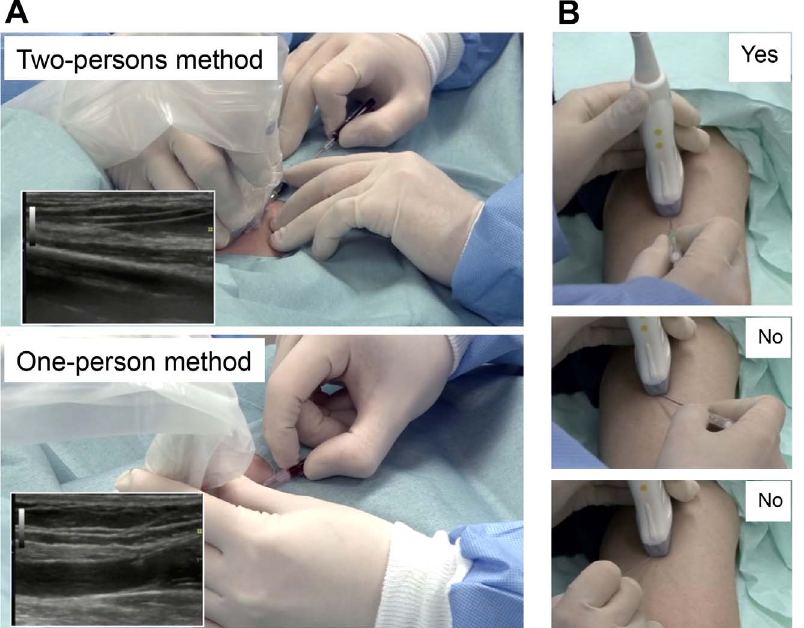
Figure 5. Real-time ultrasound-guided venipuncture. ( A ) ‘‘Two-person method’’ and ‘‘one-person method.’’ With the ‘‘two-person method,’’ the ultrasound-guidance step and the puncturing step are assigned separately to two operators. This can increase the success rate for beginners. ( B ) Tips for puncture with the correct angle. The axes between the probe and needle must be kept in one line.